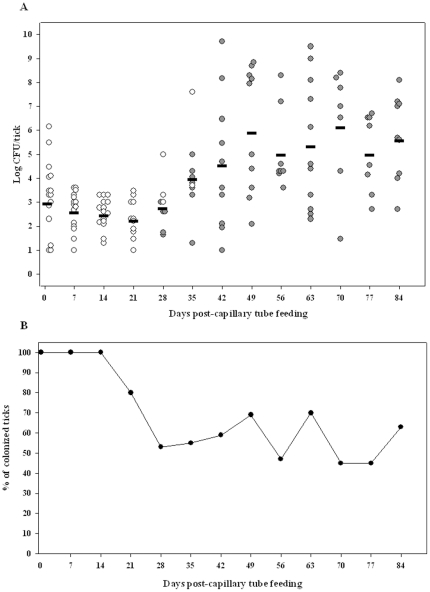
LVS is transmitted transstadially from nymphs to adults.(A) Open circles are capillary tube fed nymphs and filled circles are molted adults. The calculated mean CFU/tick for colonized nymphs and molted adults for each time point is represented by the horizontal line. For each time point up to day 84, n was 15. (B) Percentage of colonized ticks in the same experiment.